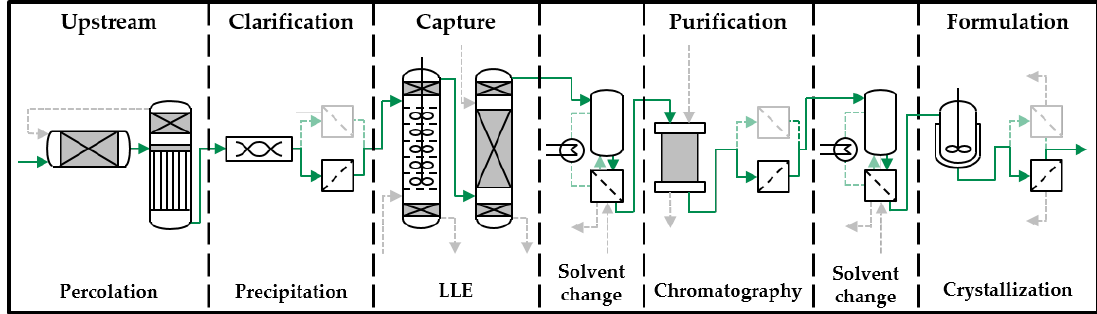
Figure 1. Basic process design for plant-based substances (LLE, liquid-liquid extraction) [10]. A description of the process shown above is given in (Part I).